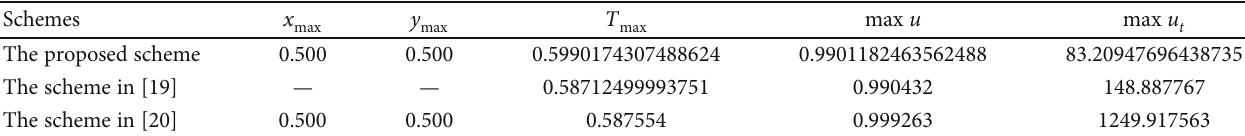
ffiffiffiffiffi p 10 , and θ = 1 without convection term.